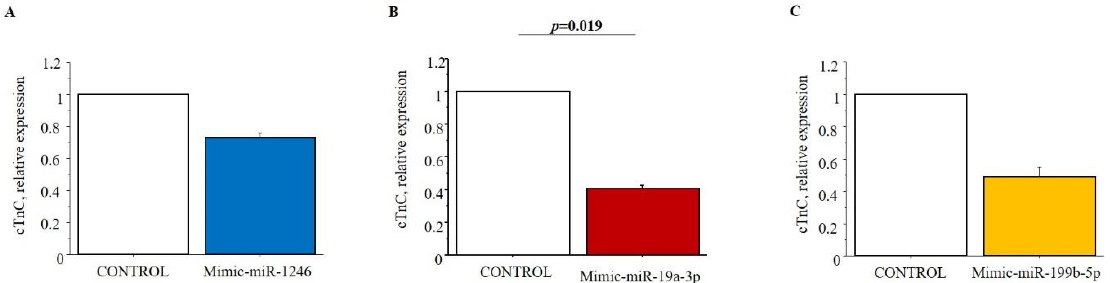
Figure 5. In vitro study results. Cardiac troponin C (cTnC) expression levels in HL-1 cell line transfected with ( A ) mimic- miR-1246; ( B ) mimic-19a-3p; ( C ) mimic-199b-5p compared to control (no treated cell). Comparison between control and transfected cells was performed by paired Student’s t-test.